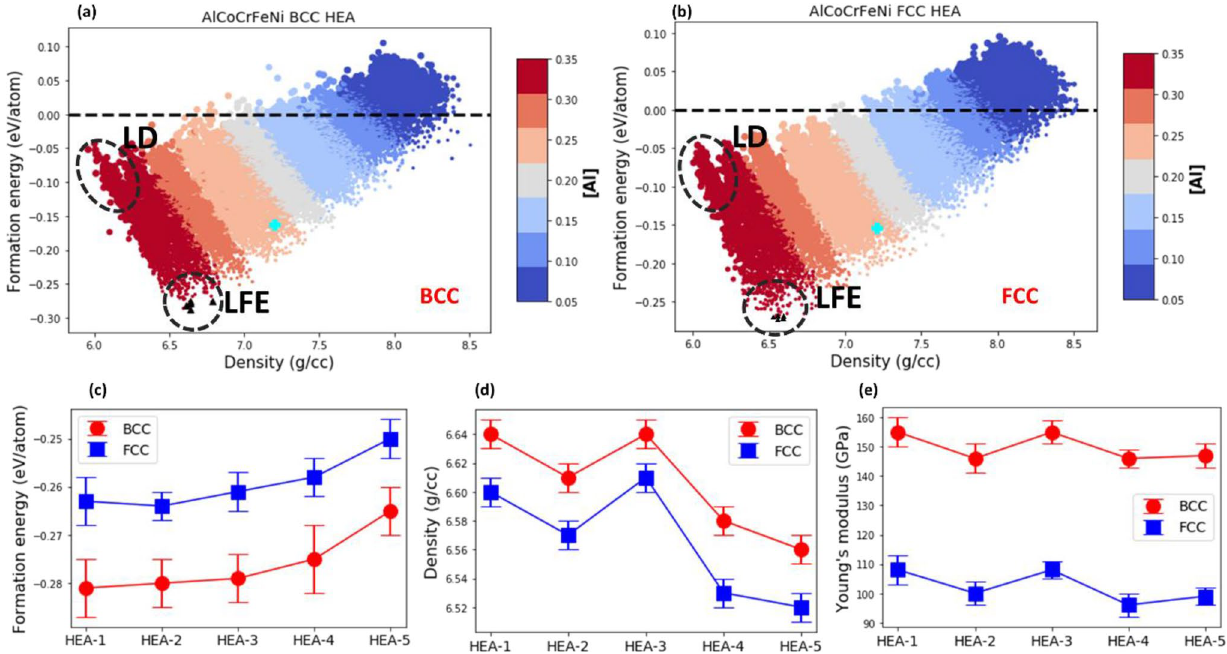
Figure 5. ( a ), ( b ) The calculated formation energy per atom vs. the mass density for AlCoCrFeNi HEA with BCC ( a ) and FCC ( b ) lattice structure. Marker color indicates the molar fraction of Al and marker size the molar fraction of Cr ( b ). Closed dashed lines outline the region of compositions with low densities (LD), and the region of compositions with low formation energies (LFE). The top five most energetically stable compositions are indicated by black triangles. The equimolar composition is indicated by cyan cross symbol ( c )-( e ) The formation energy per atom ( c ), mass density ( d ), and Young’s modulus ( e ) for the top five most energetically stable compositions of AlCoCrFeNi HEA with BCC lattice (red circles). The selected [AlCoCrFeNi] compositions are HEA-1: [0.35,0.22,0.05,0.05,0.33], HEA-2: [0.35,0.17,0.05,0.08,0.35], HEA- 3: [0.35,0.23,0.05,0.05,0.32], HEA-4: [0.35,0.15,0.05,0.11,0.34] and HEA-5: [0.35,0.16,0.06,0.11,0.32]. The formation energy, density, and elastic modulus for the same compositions of AlCoCrFeNi HEA with FCC lattice structure (blue squares) are plotted for